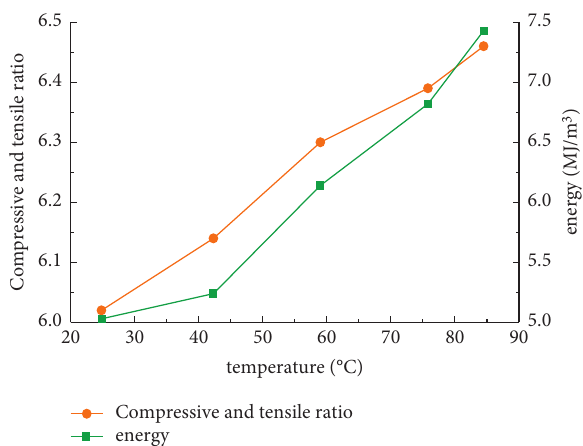
Figure 14: Variation of brittleness and energy of similar materials at different temperatures covered by the